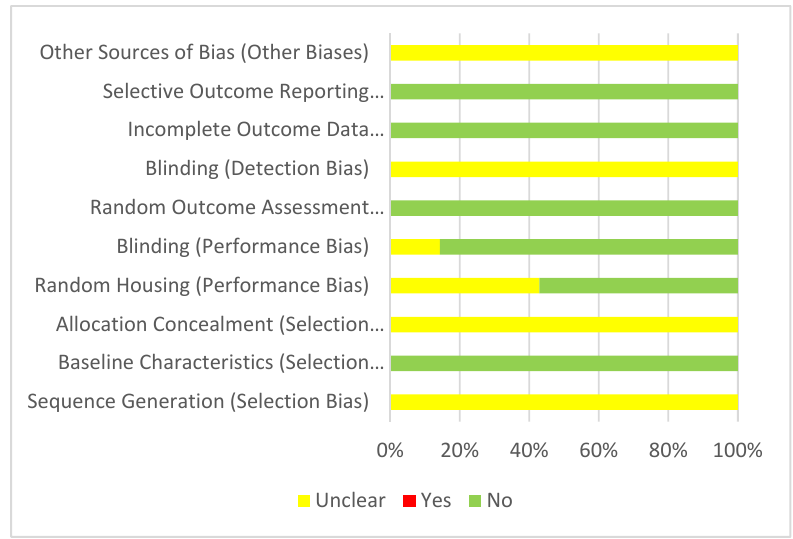
Figure 4. Risk of bias assessment for myocardial ischemia-reperfusion injury.